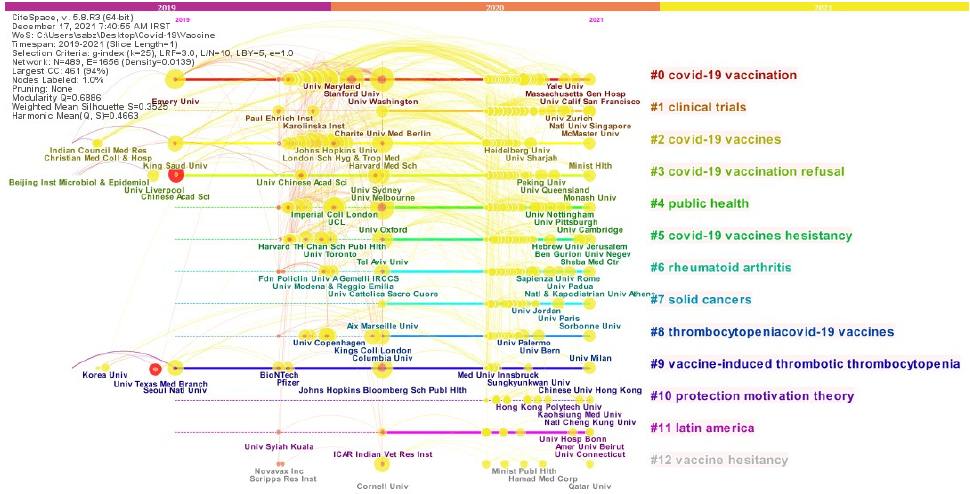
Figure 13. Timeline map of institutions in COVID-19 vaccines research based on Authors key- words.